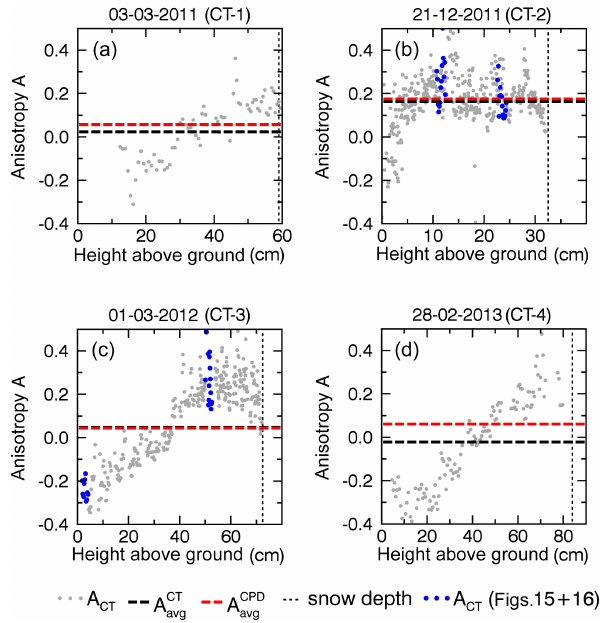
Figure 16. Vertical profiles of the anisotropy, A CT , determined from computer tomography. For comparison, we plotted in each graph horizontal lines which show the depth-averaged anisotropies, A CT avg , together with the average anisotropy, A CPD avg , determined from the radar data (Fig. 11). (a) The profile CT-1 shows 30cm of old snow with vertical structures from November/December 2010, which is covered by metamorphic snow that fell from mid-January to early February 2011 (see Fig. 7). (b) The profile CT-2 shows homogeneously distributed positive anisotropies which result from heavy snowfall during mild temperatures in December 2011 (see Fig. 8). (c) The profile CT-3 shows a thick layer with vertical struc- tures of metamorphic snow in the lower 40cm of the snowpack. In the upper 40cm horizontal structures are visible which result from fresh snowfall mid-February 2012 (see Fig. 8). (d) Alternat- ing snowfall and cold temperatures leads to an almost linearly in- creasing anisotropy in the profile CT-4 from late February 2013 (see Fig.